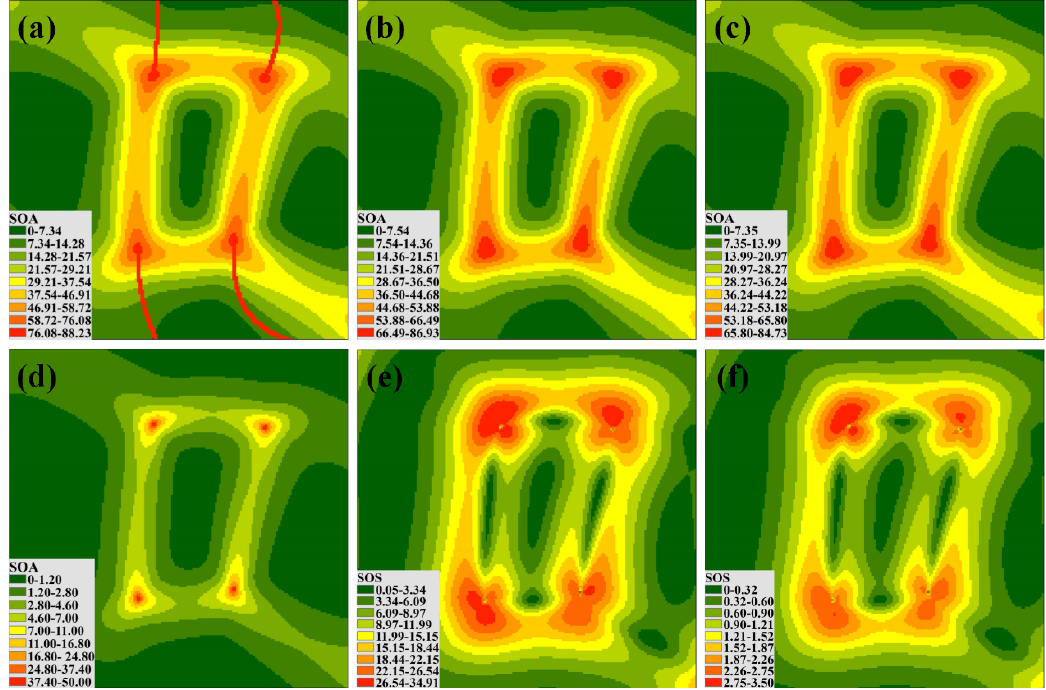
Figure 5. Slope of aspect (SoA) and slope of slope (SoS) results for the Gaussian surface using different methods. ( a ) Direct, ( b ) P–N, ( c ) senary, and ( d ) vector methods for SoA. ( e ) Direct and ( f ) vector methods for SoS. The unit is degree.